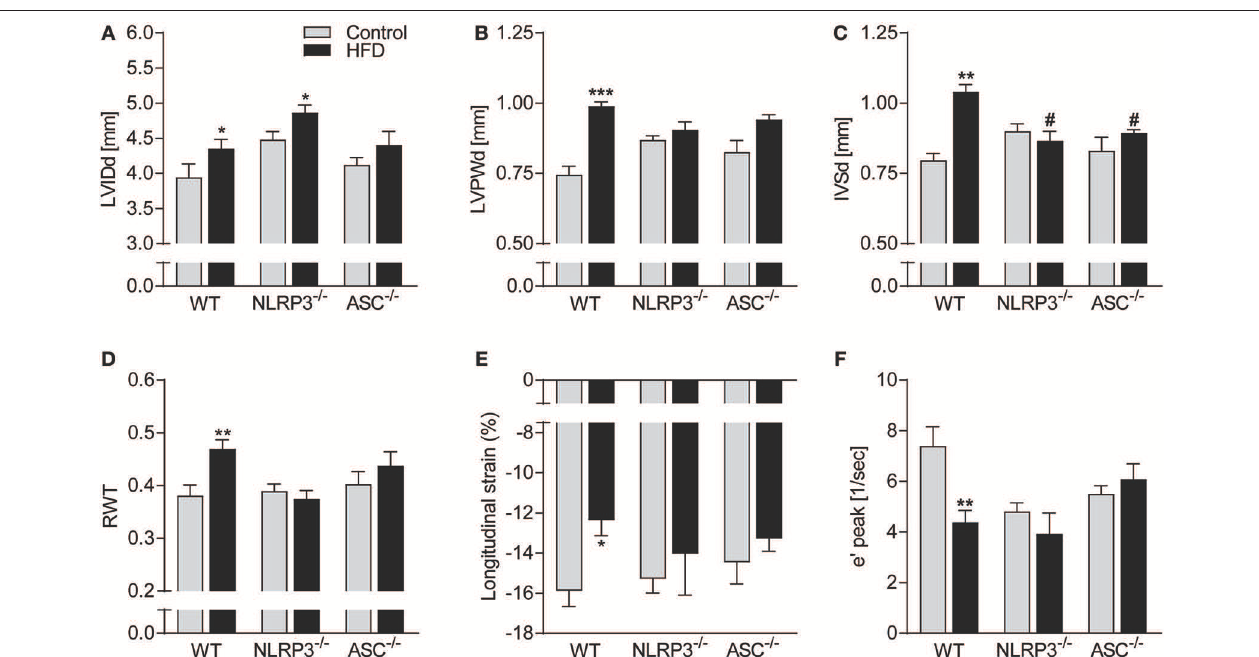
FIGURE 2 | Beneficial effect of NLRP3 and ASC deficiency on obesity-induced LV concentric remodeling and dysfunction. WT, Nlrp3 − / − , and Asc − / − ( Pycard − / − ) male mice were exposed to a high fat diet (HFD; 60 cal% fat) or a control diet for 52 weeks. Cardiac structure and function was assessed by echocardiography. WT: Control, n = 6; HFD, n = 10, Nlrp3 − / − : Control, n = 6; HFD, n = 7, and Asc − / − ( Pycard − / − ): Control, n = 6; HFD, n = 7, and cardiac magnetic resonance imaging [MRI; WT: Control, n = 6; HFD, n = 6, Nlrp3 − / − : Control, n = 6; HFD, n = 6, and Asc − / − ( Pycard − / − ): Control, n = 6; HFD, n = 6]. (A) Left ventricular internal diameter at end diastole (LVIDd), (B) LV posterior wall thickness at end diastole (LVPWd), (C) interventricular septum thickness at end diastole (IVSd), (D) LV